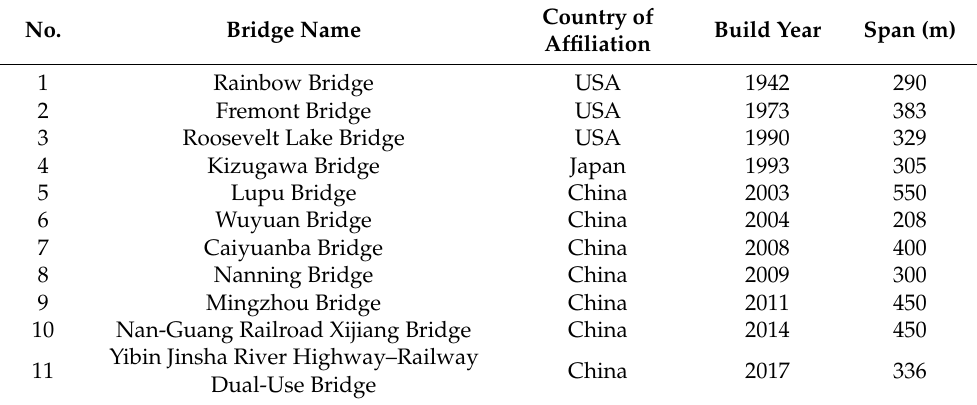
Table 1. Some steel box arch bridges built at home and abroad (arch ribs and main girder are steel